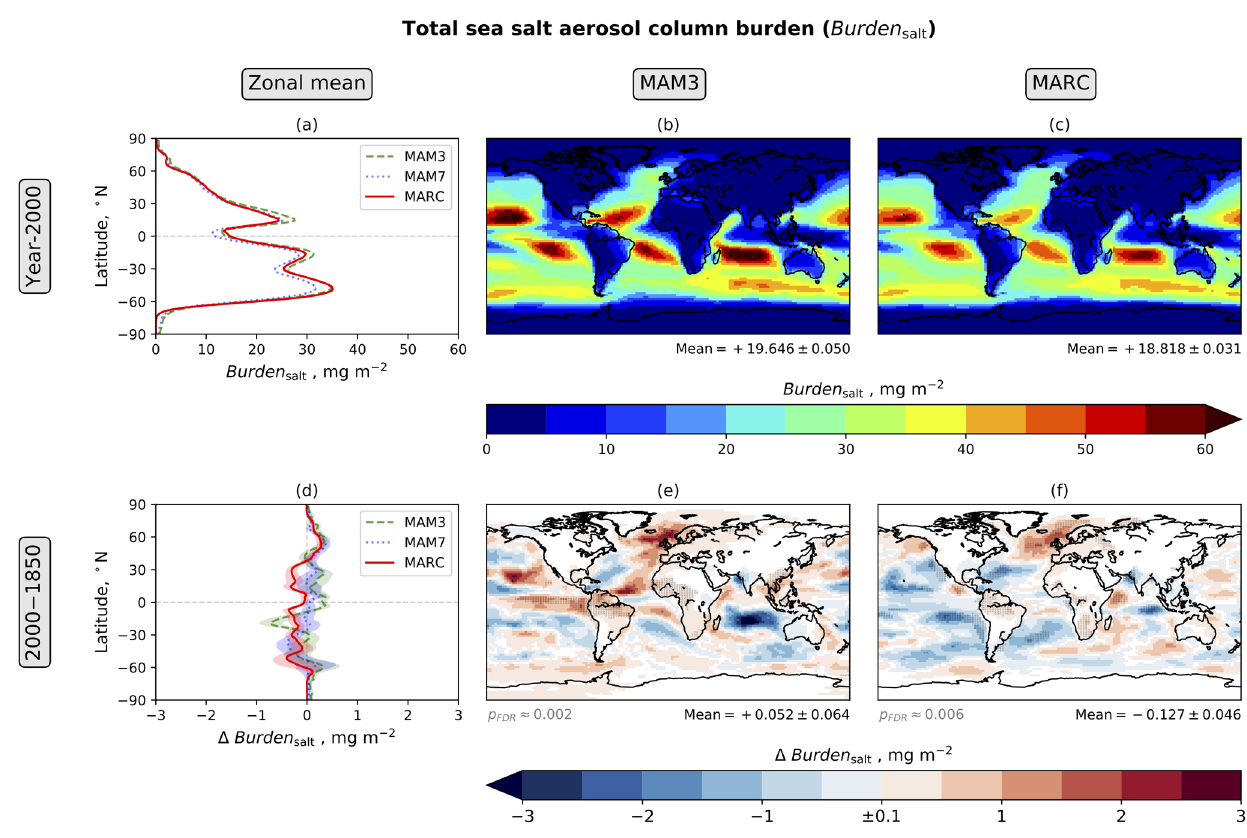
Figure 5. Annual mean total sea salt aerosol burden (Burden salt ). The figure components are explained in the Fig. 2